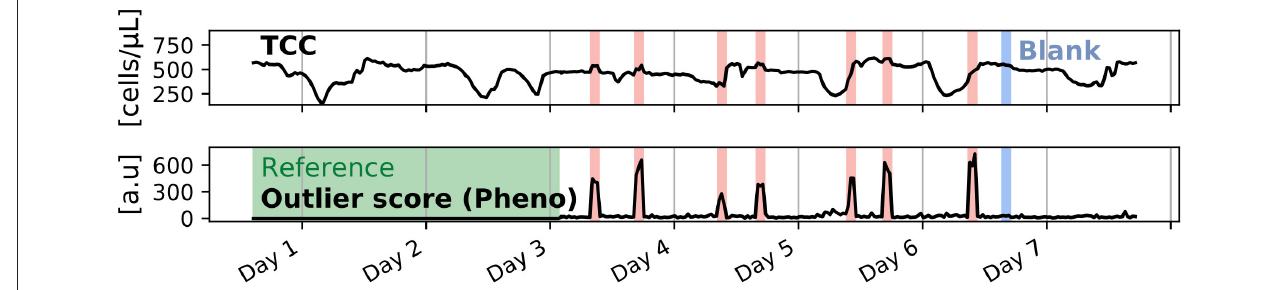
FIGURE 6 | Generalization of the MCCD outlier score to Hill diversity indices derived from PhenoFlow fingerprints, applied to the simulated water system experiment with wastewater spikes. The outlier score signal calculated with PhenoFlow features is very similar to the outlier score signal calculated through the PB features shown in Figure 5